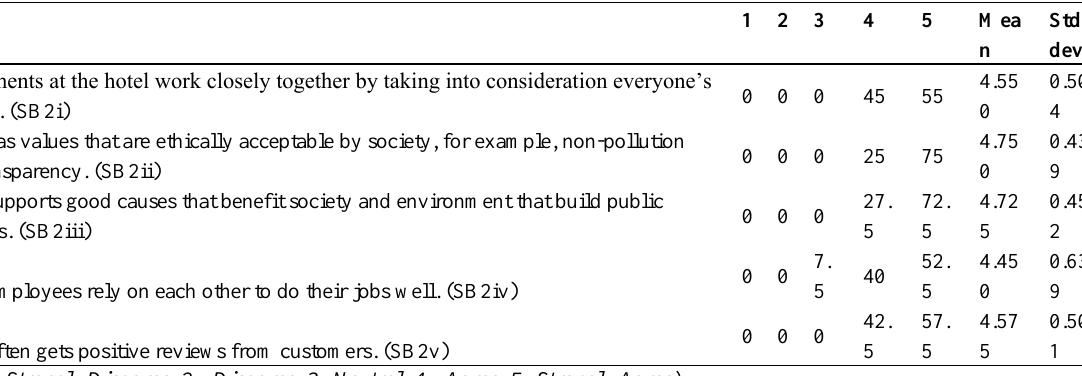
Table 2: The mean scores and distribution of Reputation